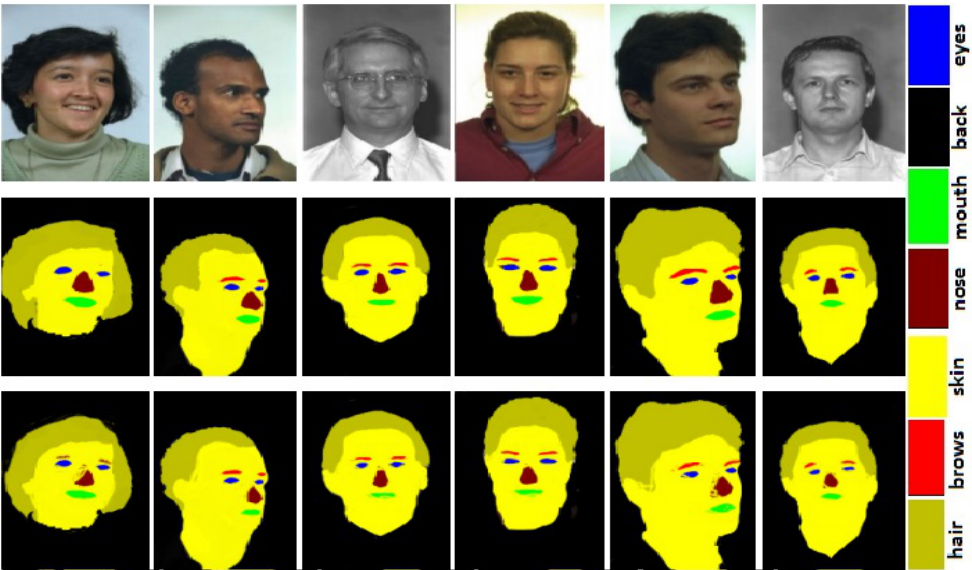
Figure 4. Original face images from FERET [31] database in row 1, ground truth in row 2, and face parsing results in row